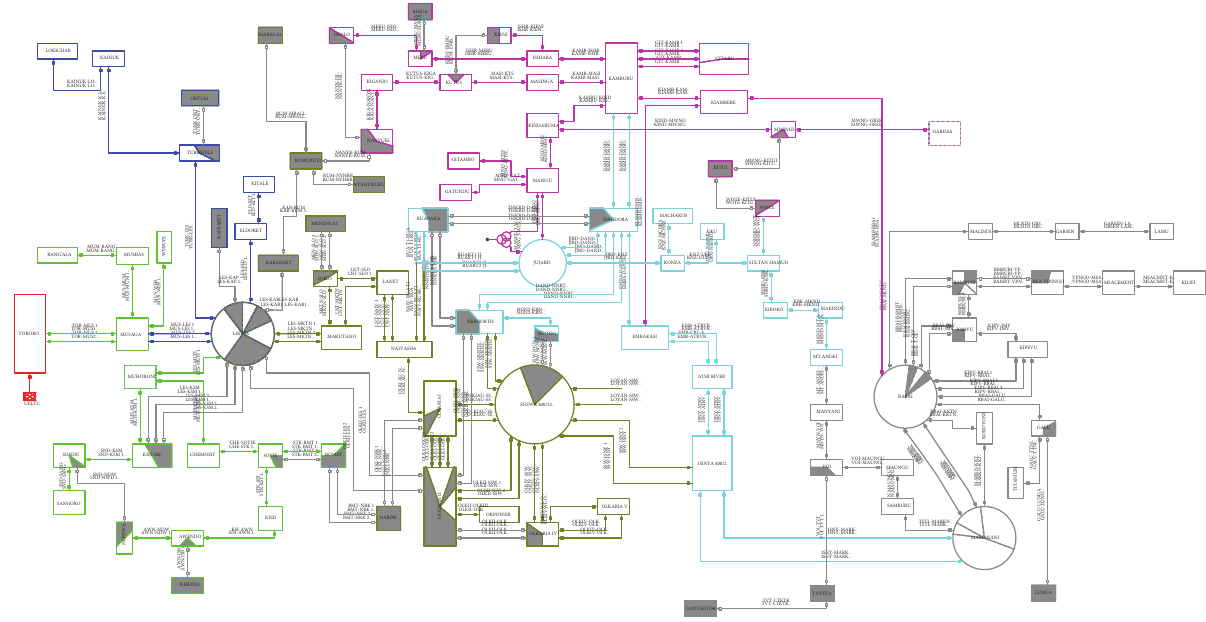
Figure 5: Kenyan transmission